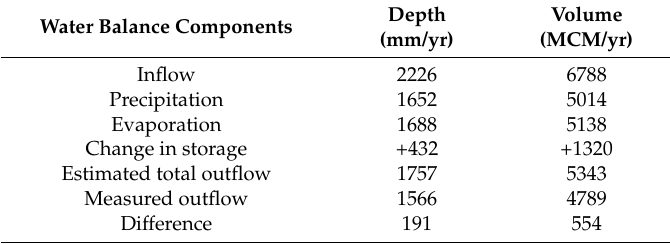
Figure 4. Cumulative values of monthly estimated total outflow and measured outflow from Lake Tana. Table 3. Annual water balance components of Lake